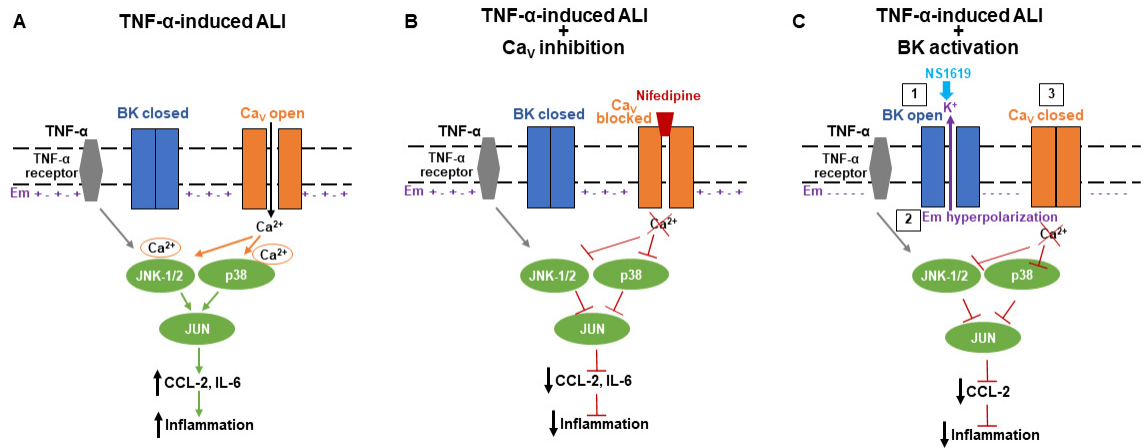
Figure 5. Proposed schematic diagram of Ca V and BK channel-mediated regulation of CCL-2 secretion during TNF- α -induced inflammation: ( A ) Given the relatively depolarized Em of endothelial cells (indicated as + - + -), the open probability for Ca V channels is high, which promotes Ca 2+ influx, the activation of Ca 2+ -dependent MAPK (JNK-1/2, p38, JUN) signaling, and downstream CCL-2 and IL-6 secretion and inflammation. ( B ) Inhibition of L-type Ca V channels with Nifedipine prevents Ca 2+ influx-mediated MAPK activation and decreases downstream CCL-2 and IL-6 secretion. ( C ) BK channel opening with NS1619 results in Em hyperpolarization (indicated as - - - -) and the closing of Ca V channels, thus preventing Ca 2+ -dependent MAPK activation and downstream CCL-2 secre- tion.